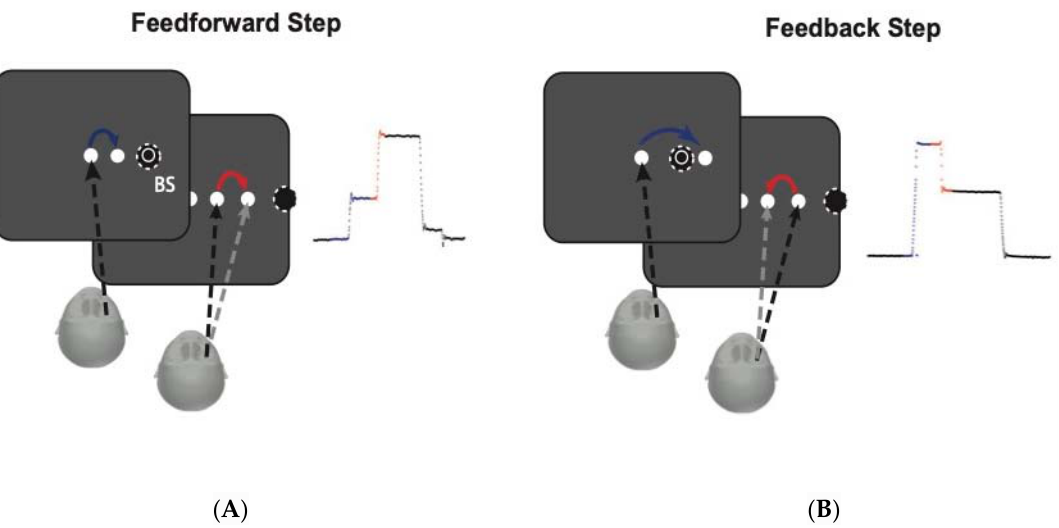
Figure 1. Example of double-step task using the blind spot to create the saccade contingent display changes: ( A ) The forward step task consists of a screen with three targets but the participants can only see two targets at first because the third target is located in the blind spot (BS). The participants initially fixate the central point and then move their gaze to the other visible point. Shortly after the first saccade begins, the hidden point to the right of the first target is revealed as the blind spot has moved away from its location. After landing on the first target, the participants then make a saccade to this newly visible point. The left panel shows the amplitude for eye position for each saccade (blue and red arrows). ( B ) The back step task is similar to the forward step with the difference that the hidden target in the blind spot is located between the two visible points. The participants initially fixate the central point and then move their gaze to the other visible point. Shortly after the first saccade begins, the hidden point to the right of the first target is revealed once the blind spot has moved away from its location. After landing on the first target, participants then make a saccade to this new point. The left panel shows the amplitude for eye position for each saccade (blue and red arrows).